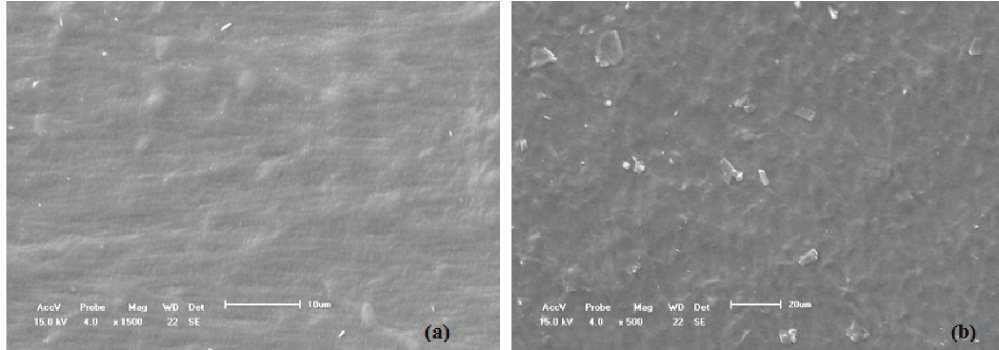
Figure 5. SEM micrographs of the surface of the PE (a) and PE